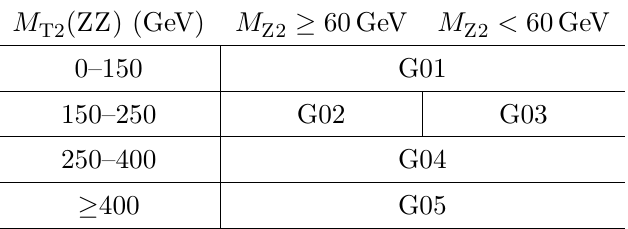
Table 10 . Definition of the search regions for events with 4 light leptons, including 2 separate OSSF pairs